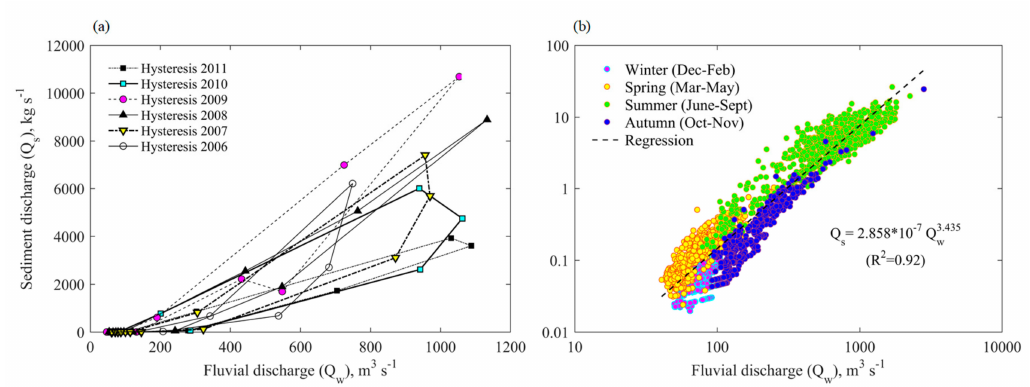
Figure 10. ( a ) Seasonal hysteresis loop of the sediment load. ( b ) Suspended sediment–discharge rating